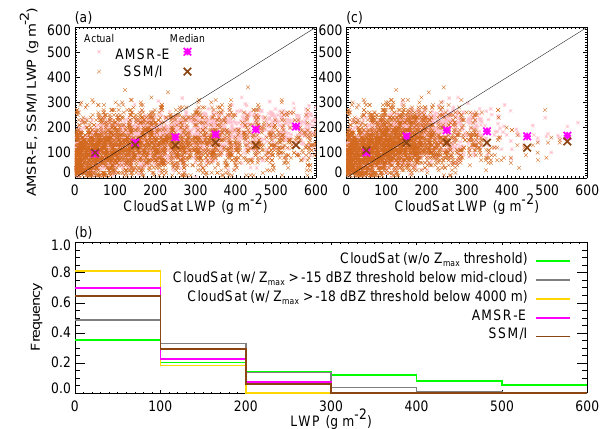
Fig. 1. (a) Non-zero liquid water paths (LWPs) from AMSR- Figure 1. (a) Non-zero liquid water paths (LWPs) from AMSR-E and SSM/I compared to E and SSM/I compared to those from CloudSat averaged over those from CloudSat averaged over 0.25 ° × 0.25 ° grid boxes within 12 ° -25 ° S and 70 ° -90 ° W 0.25 ◦ × 0.25 ◦ grid boxes within 12 ◦ –25 ◦ S and 70 ◦ –90 ◦ W in in October-December 2006-2008. (b) The frequency distribution of LWP per 100 g m -2 bin October-December 2006–2008. (b) The frequency distribution of for all good-quality CloudSat profiles, CloudSat profiles with suspected precipitation LWP per 100gm − 2 bin for all good-quality CloudSat profiles, contamination removed based upon a maximum reflectivity Z max > -15 dBZ below the CloudSat profiles with suspected precipitation contamination re- apparent middle of the cloud and Z max > -18 dBZ below 4000 m similar to Leon et al. (2008), moved based upon a maximum reflectivity Z max > –15dBZ be- AMSR-E, and SSM/I. low the apparent middle of the cloud and Z max > –18dBZ below 4000m similar to Leon et al. (2008), AMSR-E, and SSM/I. (c) Same as in (a) except for CloudSat profiles with suspected precip- itation contamination removed based upon a maximum reflectivity Z max > − 15dBZ below the apparent middle of the